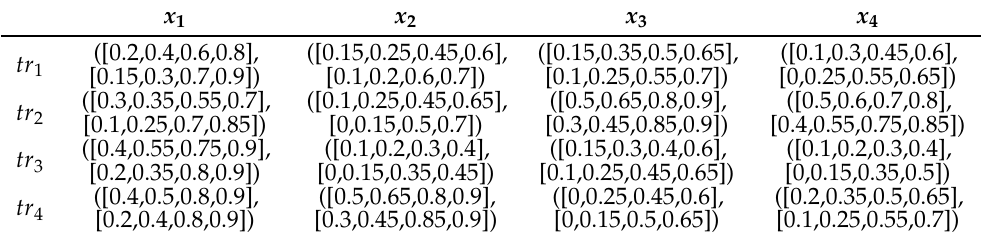
Table 1. Expert r 1 ’s decision matrix ˜ D 1 .